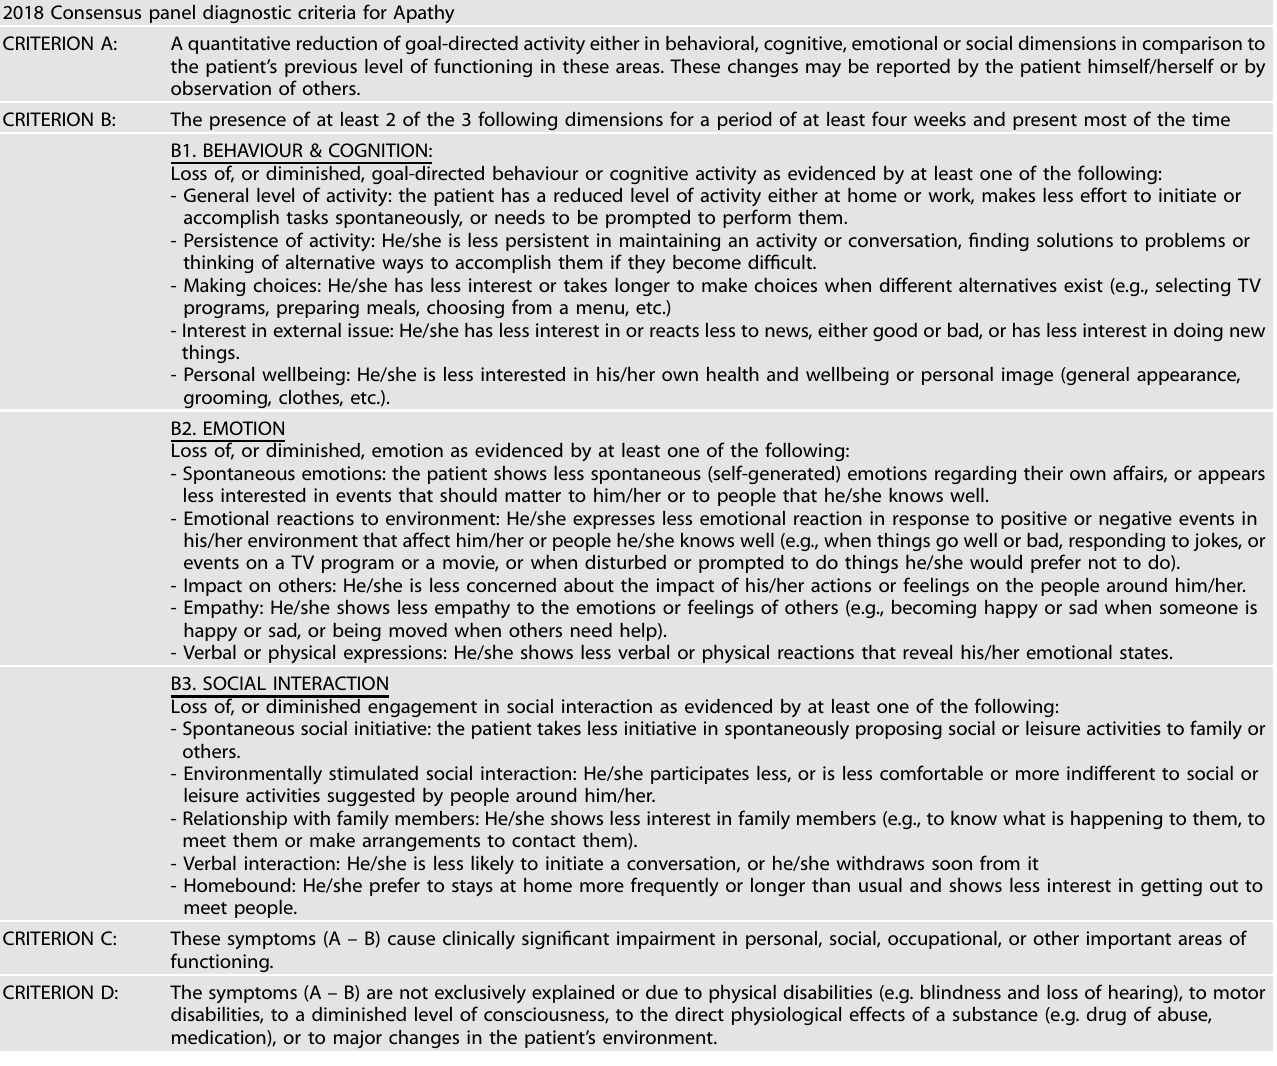
Table 2. 2018 Consensus panel diagnostic criteria for apathy [6] (reprinted with